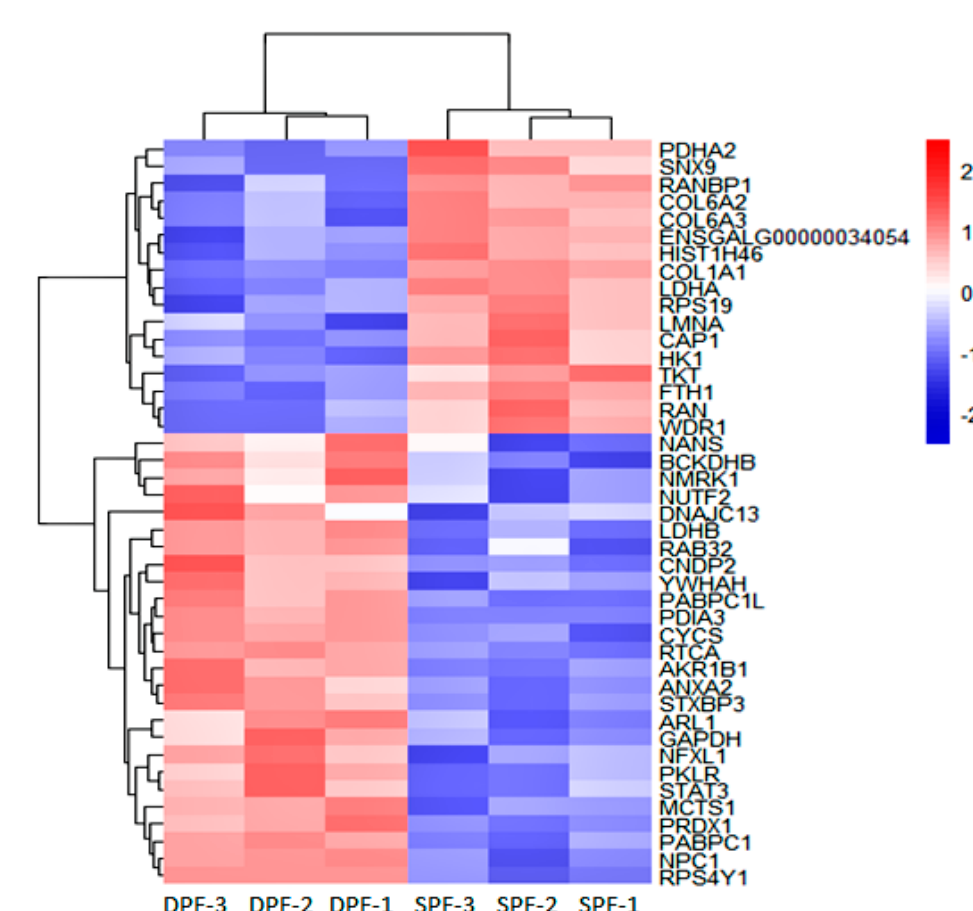
Figure 4. Protein profile obtained by labeled free TMT-based LC–MS/MS Analysis. Heat map showing the top DEPs and representing the distribution of DEPs, the differential proteomic ( p -value < 0.05 and FC ± 1.2). Pink and blue bars showing proteins that are significantly up and downregulated. The SPF stands for small primary follicle and DPF for the developed primary follicle. Only the recognized proteins were displayed in the heat map.